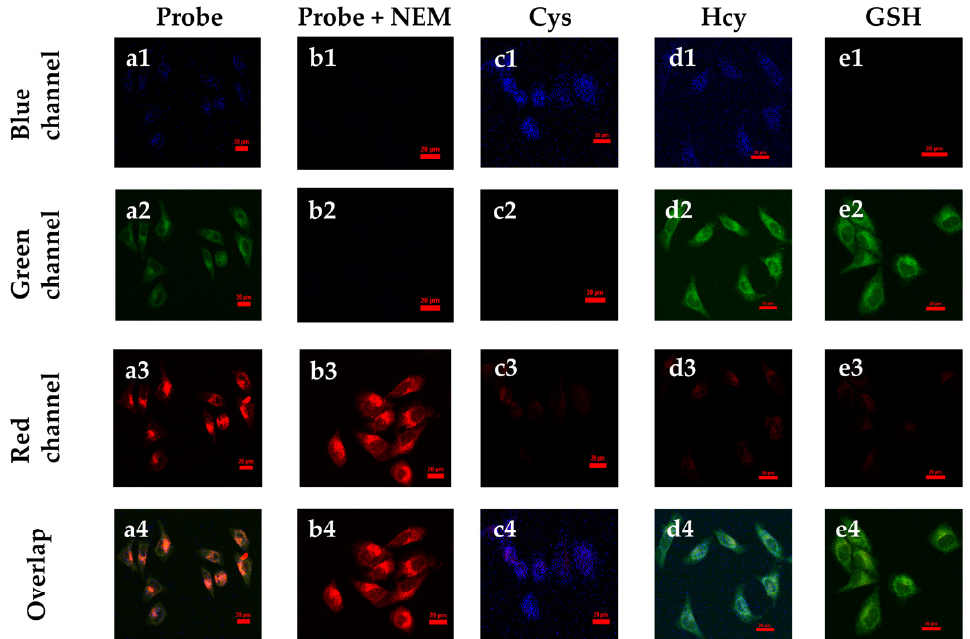
Figure 5. Confocal fluorescence images in HeLa cells. ( a1 – a4 ) Cells incubated with SWJT-14 (20.0 µ M) for 40 min. ( b1 – b4 ) Cells were incubated with NEM (200.0 µ M) for 30 min, followed by the addition of SWJT-14 and continued incubation for 40 min. ( c – e ) Cells were incubated with NEM for 30 min, followed by the addition of biothiol for 30 min and then the probe was added for 40 min. ( c1 – c4 ) Cys